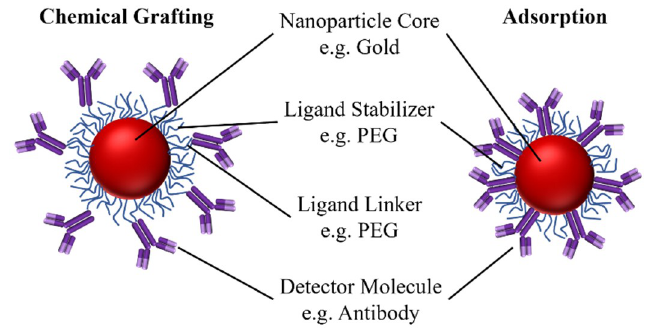
Figure 4. A schematic of immunoprobes where antibodies are attached to the NP core covalently, i.e., through chemical grafting, or physicochemically, i.e., through adsorption.